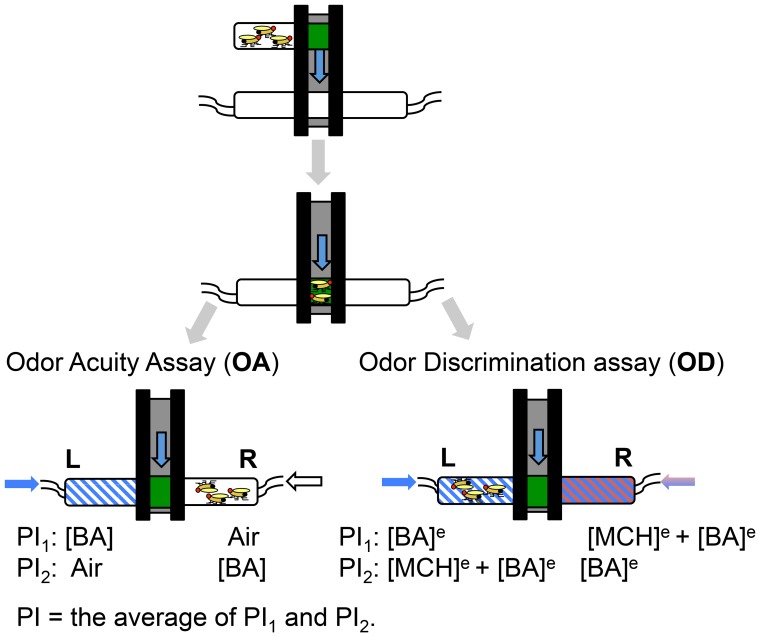
Fly odor acuity (OA) and odor discrimination (OD) assays.Fly odor acuity (OA) and odor discrimination (OD) were tested using T-maze apparatus. Flies loaded into T-maze were dropped to a choice point between [BA] and air in the odor acuity assay or between [BA]e and [MCH]e+[BA]e in the odor discrimination assay. To avoid an inherent directional reference in assays, an odor of a pair was delivered from one end of T-maze during the first trial (PI1) and from the opposite end during the second trial (PI2). A test comprised two trials. The performance index (PI) of a test is the average of PI1 and PI2. When the equilibrium concentrations of BA ([BA]e) and MCH ([MCH]e) were delivered from the opposite ends of T-maze, flies would show no preference for either [BA]e or [MCH]e by equally distributing between the two end-tubes. Flies with health odor discrimination would detect the presence of [BA]e, a foreground odor, in the background of [MCH] e and run to [MCH]e tube, avoiding the [MCH]e+[BA]e tube. The formula for PI calculation was expressed as a percentage of the absolute number of flies that were differentially distributed between two end-tubes, divided by the total number of flies in a trial. PI1 or 2 = 100%×|(# of L)- (# of R)|/(# of total flies in a test).